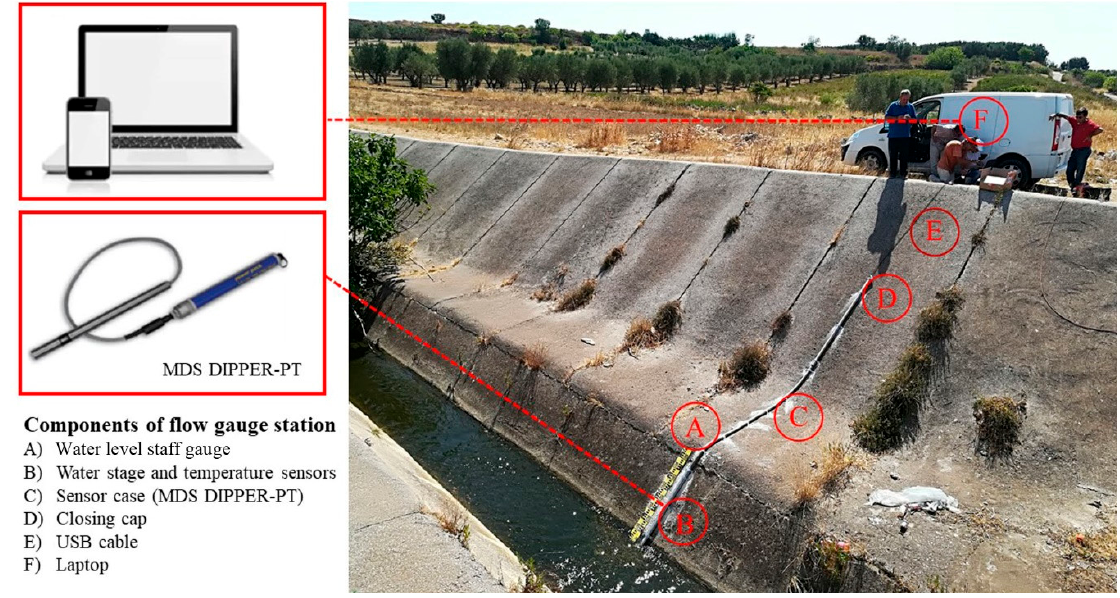
Figure 2. Flow gauge station (Station B).